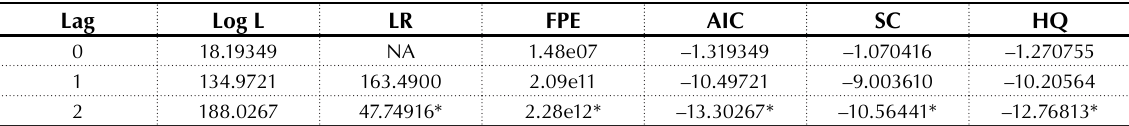
Table 2. The lag length selection criterion